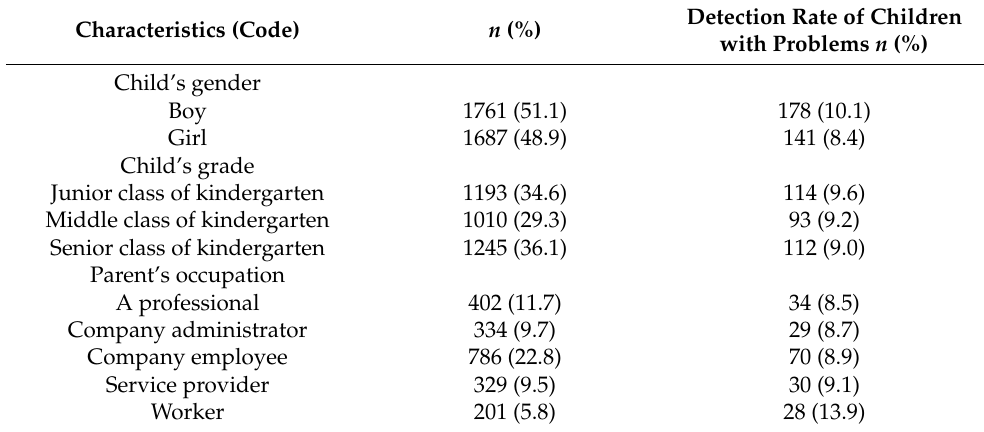
Table 1. Demographic characteristics of the participants (N =